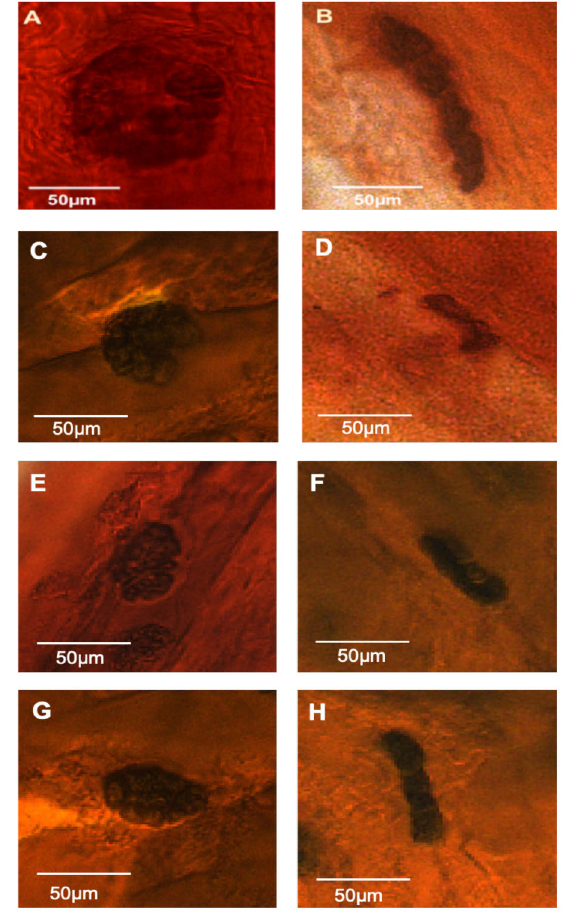
Figure 3. Comparison between neuromuscular junction morphol- ogy in biceps ( A ), triceps ( C ), fi nger fl exor ( E ), and fi nger extensor ( G ) muscles of the control group and the same muscles in the diabetes mellitus group ( B , D , F , H ). Scale bar: 50 m